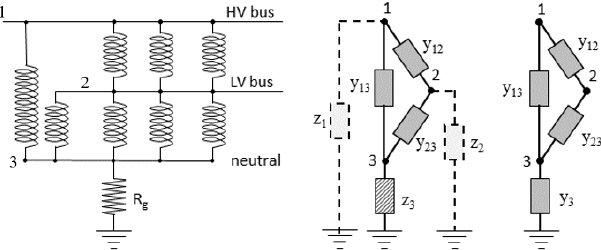
Figure 1. Substation with a two-winding transformer and three autotransformers and the equivalent circuits for the LP and LPm